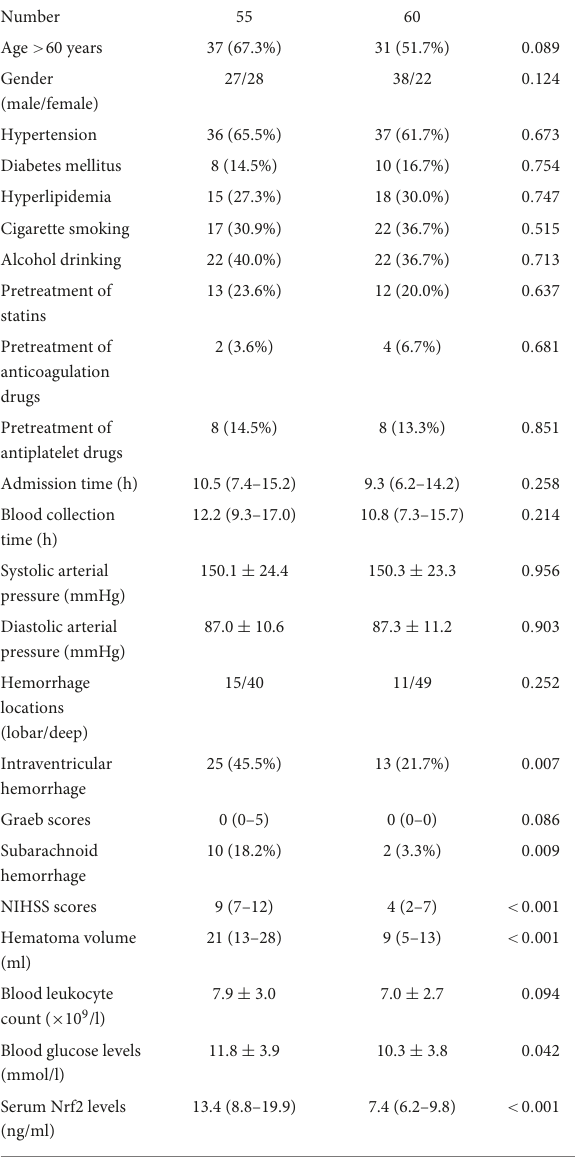
TABLE 5 Factors associated with 90-day functional outcome after acute intracerebral hemorrhage (ICH).